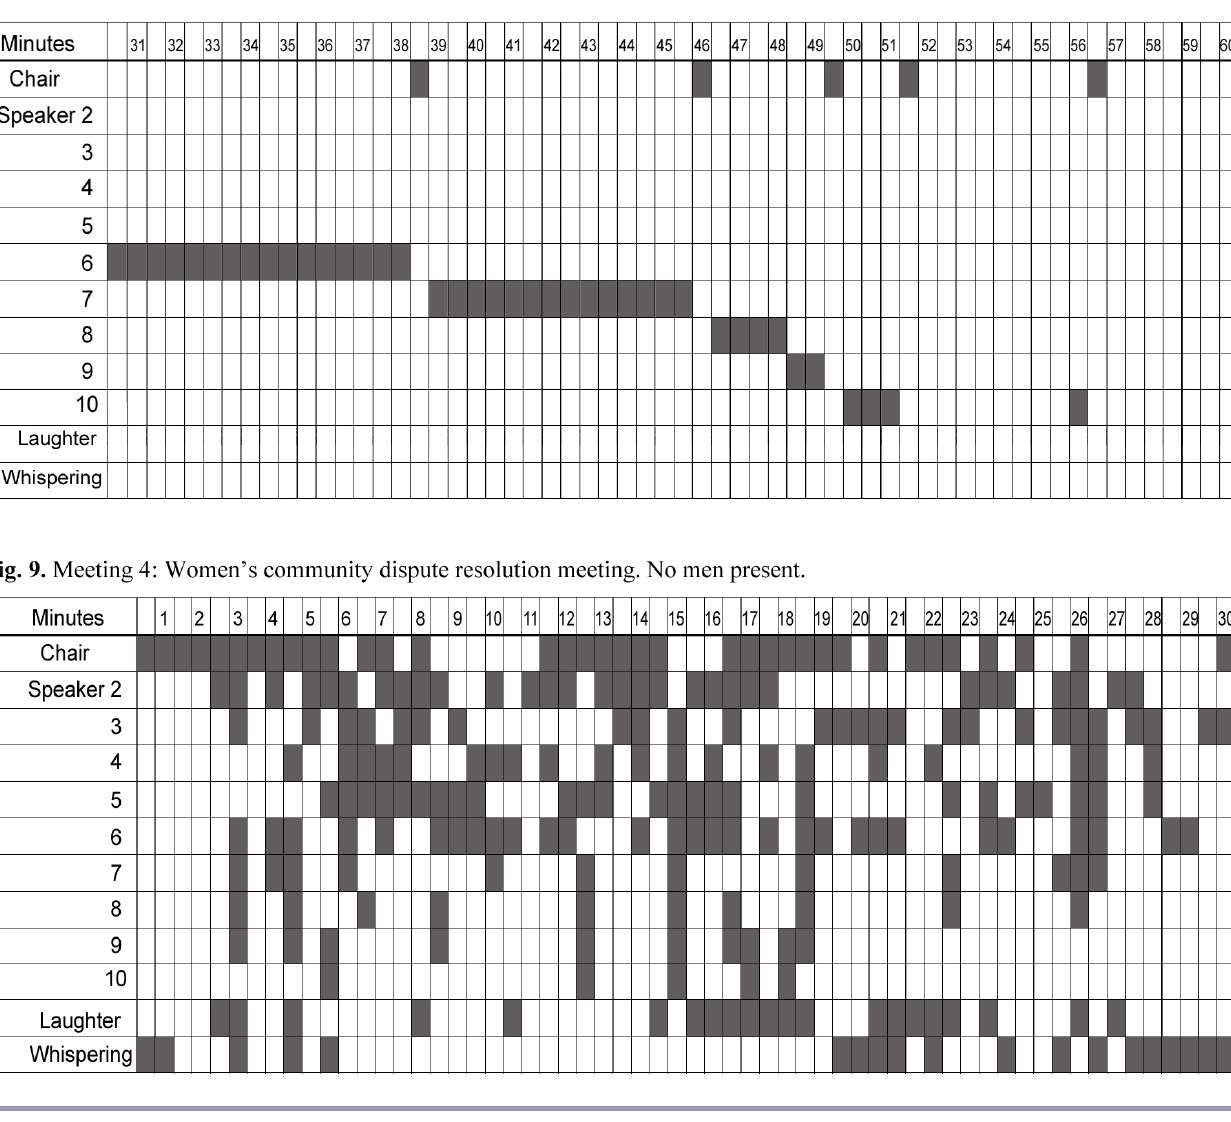
Fig. 8 . Second 30 minutes of meeting 3: Men’s dispute resolution meeting.